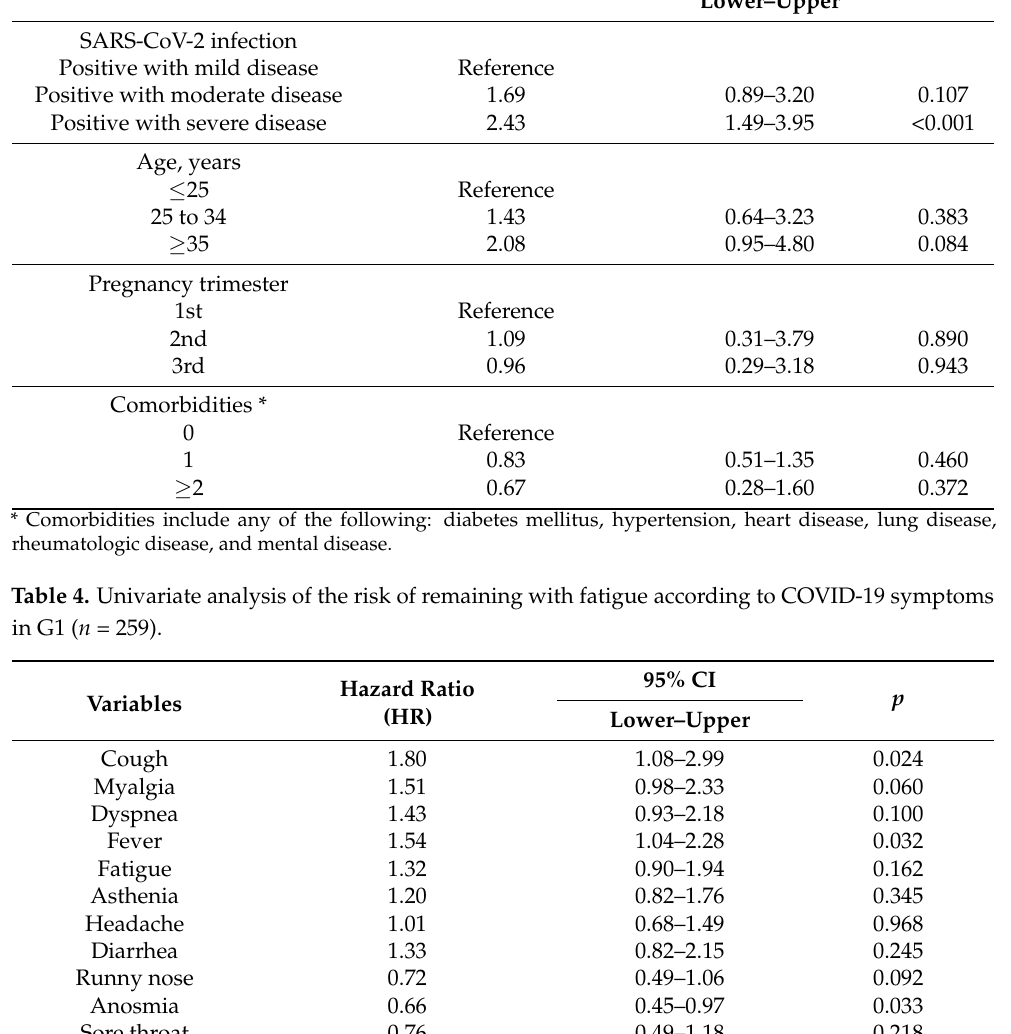
Table 3. Risk of remaining with fatigue according to maternal COVID-19 severity. Data presented here are for G1 only, n = 259, of whom 178 had fatigue at any point and are included here. Variables